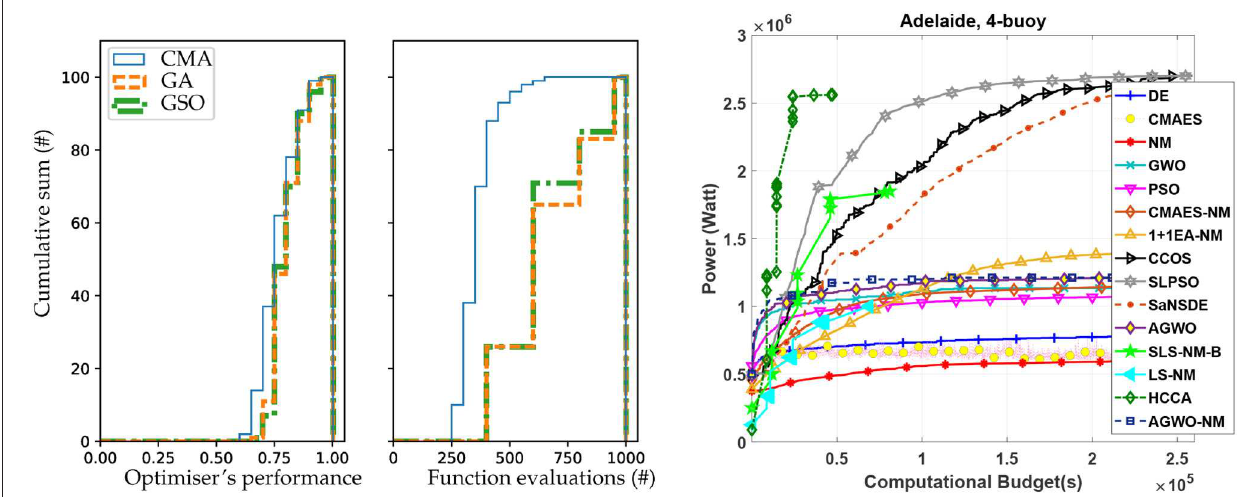
FIGURE 16 | (Left) Convergence rates of three optimization algorithms (CMA, GA and particle swarm, GSO) for the optimization of the number of WECs and their positions in a park, showing that the CMA requires fewer iterations to converge but results in slightly lower park performance ( Ruiz et al., 2017). (Right) Convergence rate for many algorithms to optimize the layout and PTO parameters for a system of four WECs (Neshat et al.,